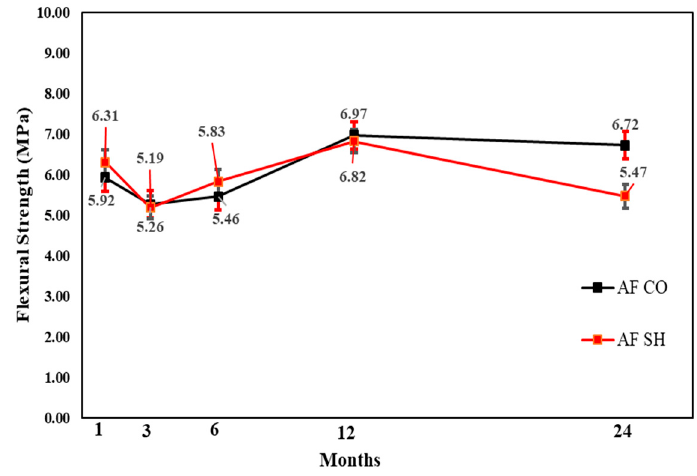
Figure 19. AF accelerator mix flexural strength by age.